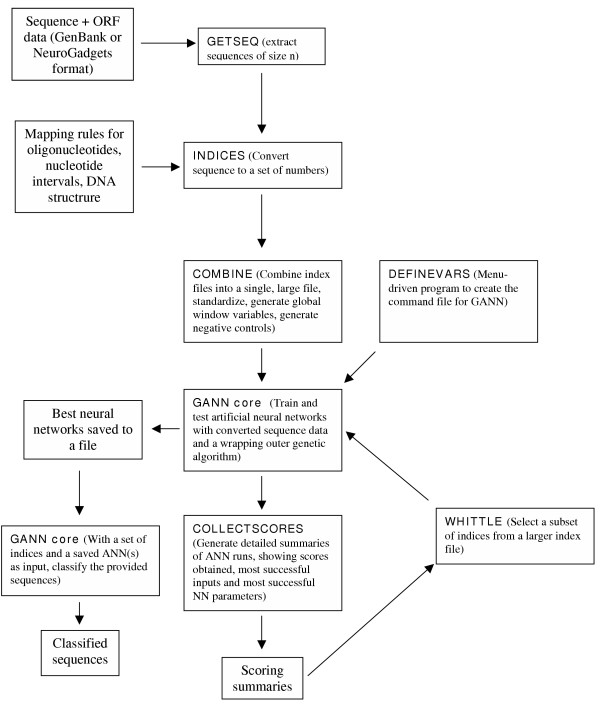
Programs and data flow for GANN.